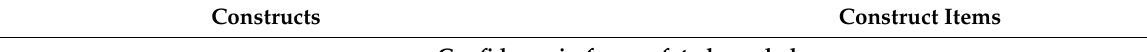
Table 2. Confidence in farm safety knowledge and parenting style survey